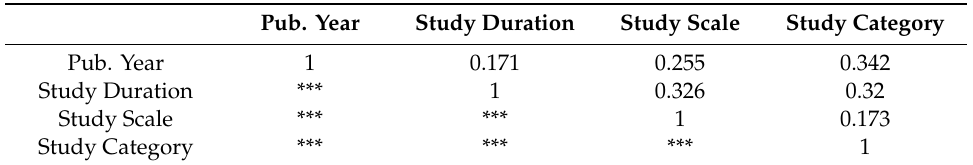
Table 2. Correlation matrix of key study parameters. All correlations are significant at a 99% confidence interval (***). Study category rescaled to 1–4, representing the four levels of analysis from purely methodological to water quality science